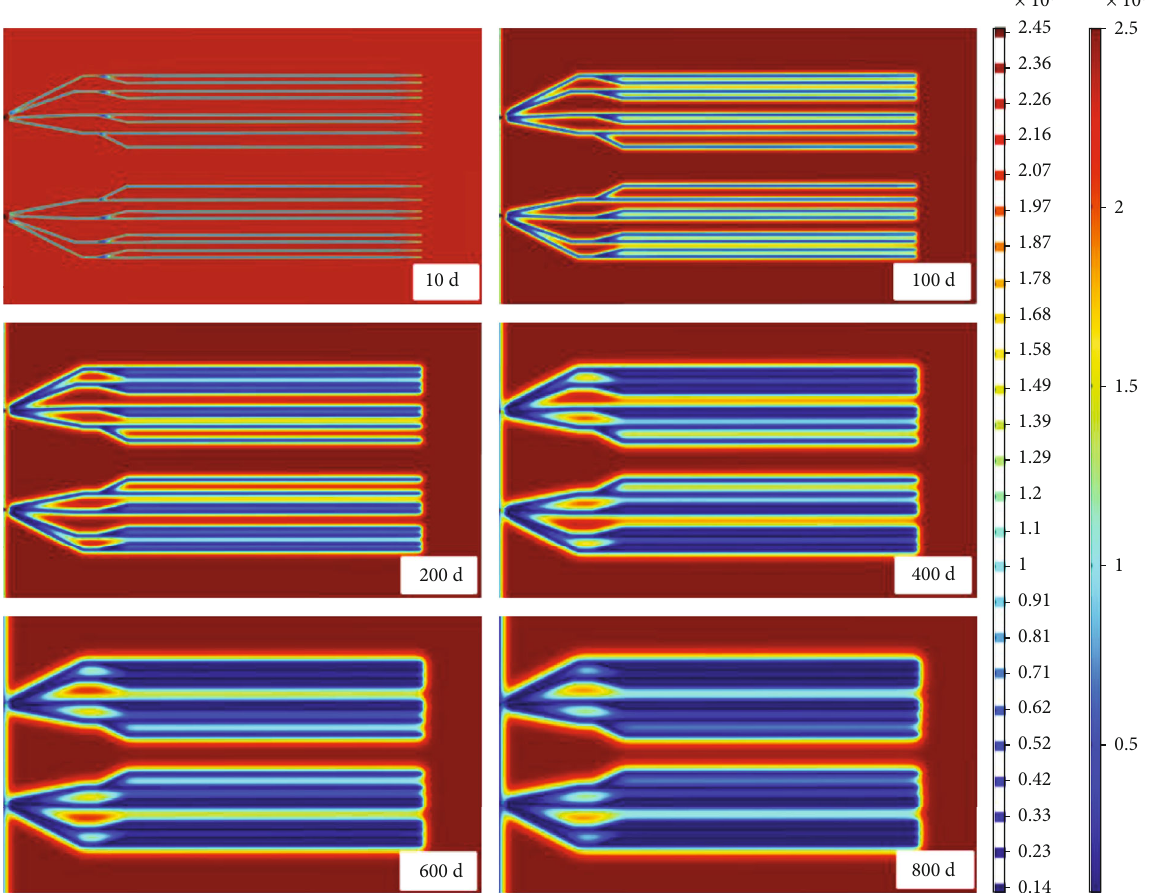
Figure 3: Borehole gas pressure variation under di ff erent extraction time.